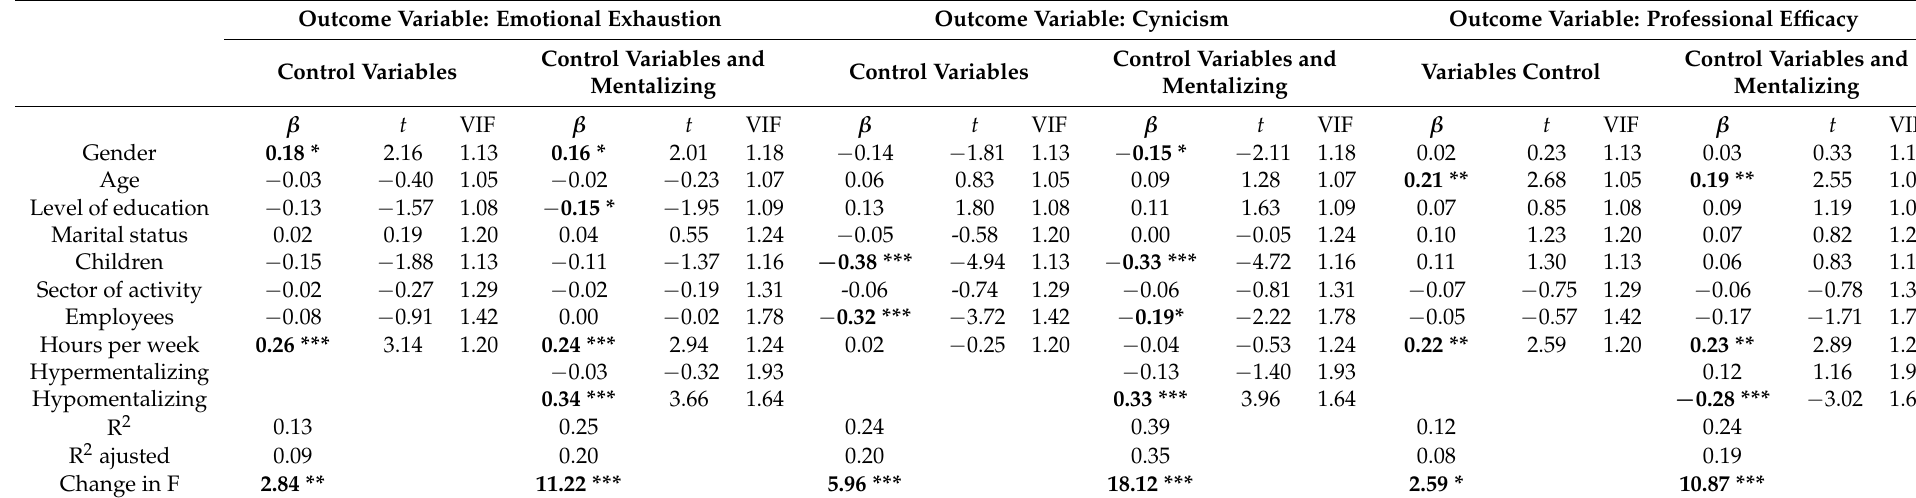
Table 2. Hierarchical linear regression of the relationship among burnout dimensions and mentalizing dimensions. Outcome Variable: Emotional Exhaustion Outcome Variable: Cynicism Outcome Variable: Professional